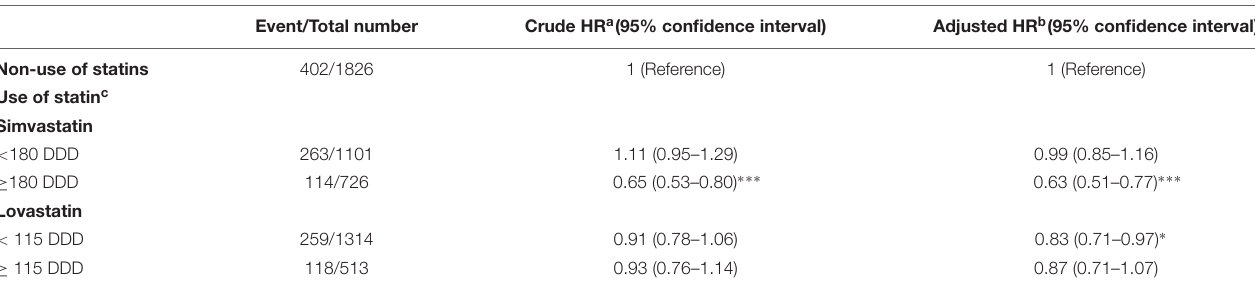
TABLE 3 | Prescribed statins reduce the mortality of PCa